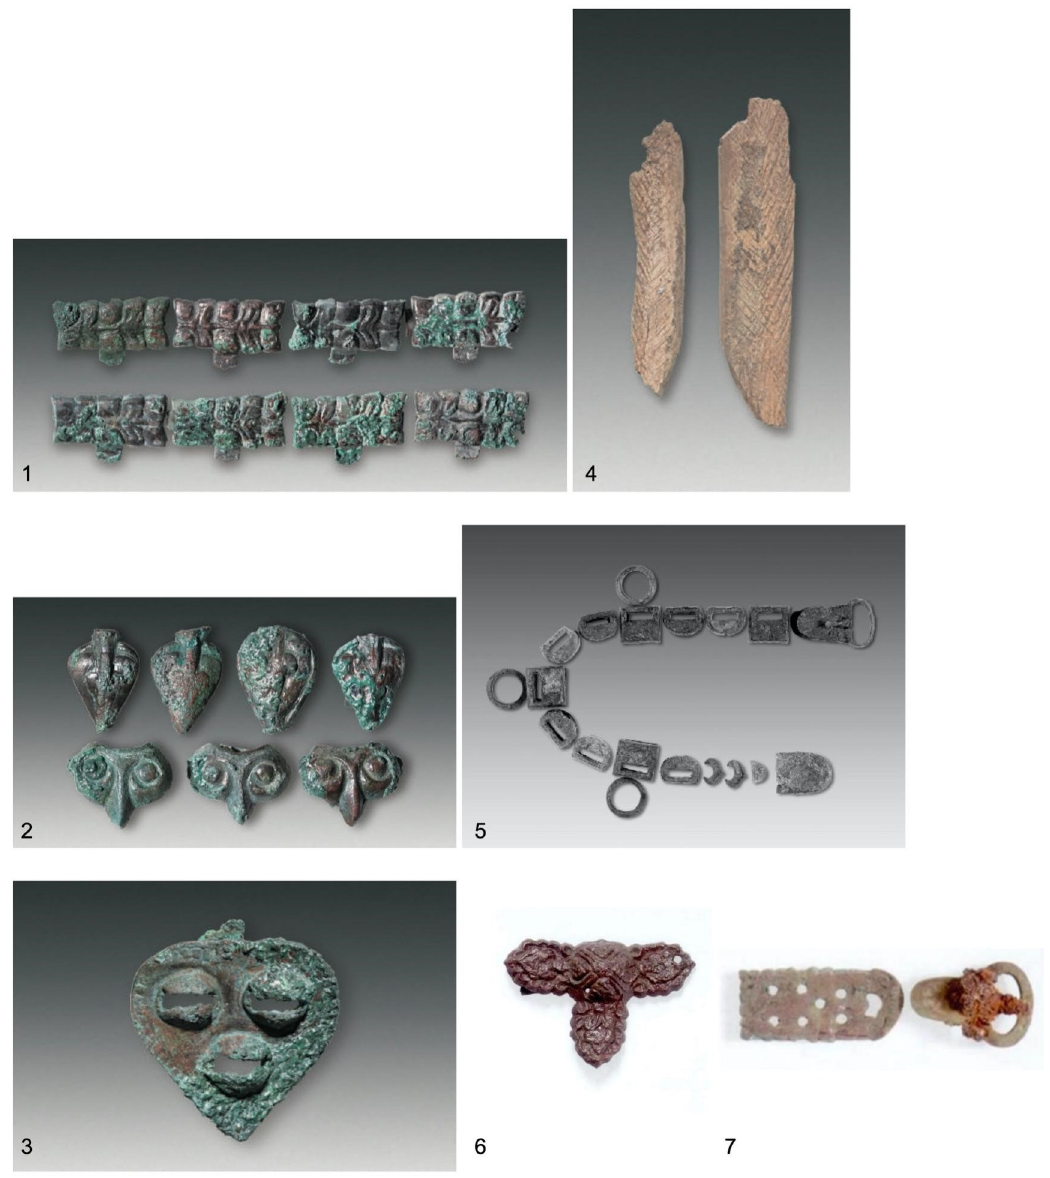
Fig 15. 1–3: bronze ornaments from M21 and 4: bone bow grip from M66 of Ningjiahe Reservoir Cemetery [49]. 5: bronze belt parts from M43 of the site of Gangou [51]. 6 and 7: bronze ornaments from M16 of Xigou Cemetery [48]. Scale not provided in original